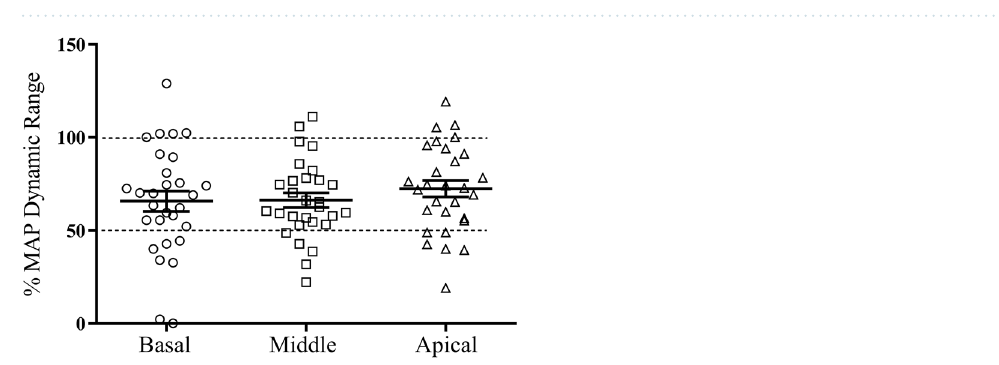
Figure 4. The left figure shows MAP’s C-levels and T-levels (in charge units), and the right figure shows MAP’s dynamic range (DR) at electrodes 3, 12, and 21. Round and triangle symbols in the left panel represent C-levels and T-levels for individual children with CND, respectively. The rhombuses in the right panel represent DRs for individual children with CND. The boxes represent mean scores. The error bars represent ± 1 SD. * represents p < 0.05; ** represents p < 0.01.